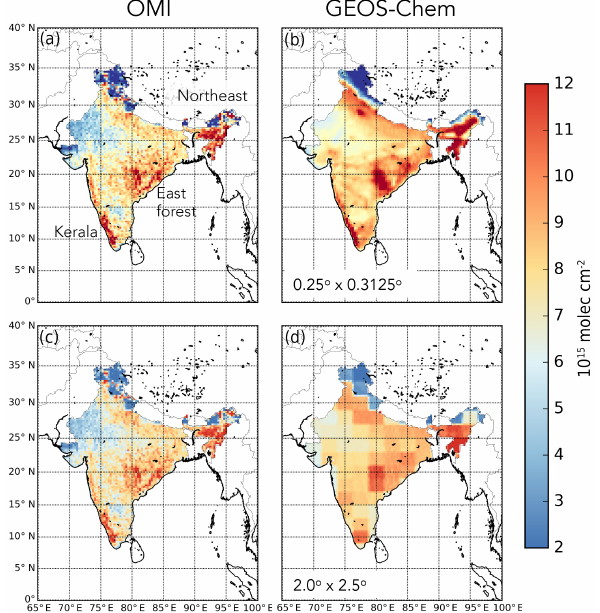
Figure 5. Annual mean clear-sky (a, c) OMI and (b, d) GEOS- Chem HCHO vertical columns (10 15 moleccm − 2 ) over India for 2014. The OMI vertical columns are described on the 0 . 25 ◦ × 0 . 3125 ◦ GEOS-Chem grid. These vertical columns are transformed from observed slant columns using AMFs informed by the distribu- tion of HCHO described by the (a, b) nested 0 . 25 ◦ × 0 . 3125 ◦ and (c, d) standard 2 . 0 ◦ × 2 . 5 ◦ GEOS-Chem grid. Data exclusion crite- ria are described in the main text. The model is sampled at the time and location of each observed scene.